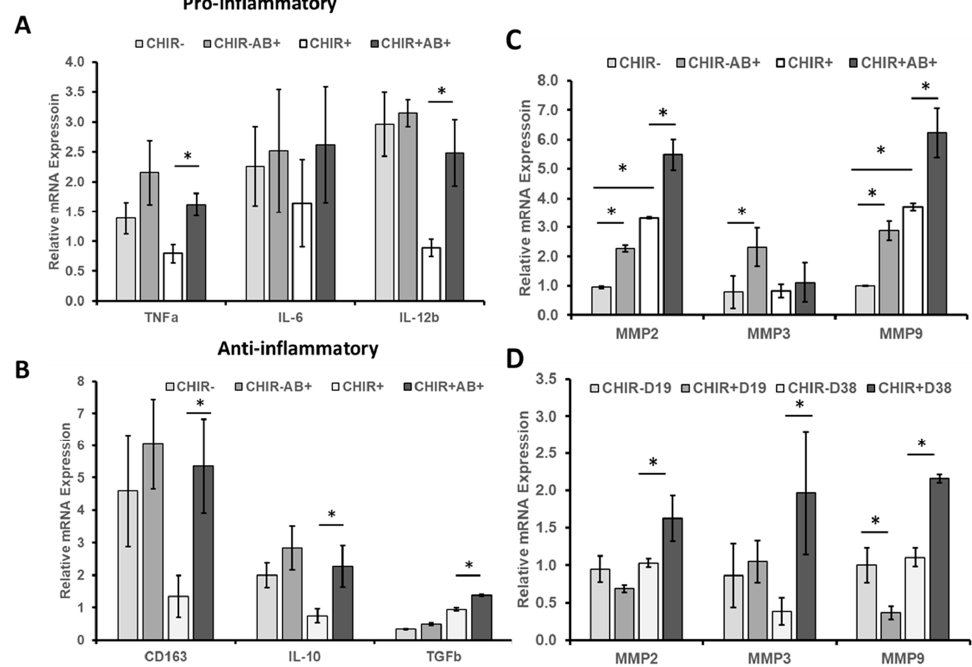
Figure 4. Inflammatory response to A β 42 oligomer stimulation for ChP organoids of CHIR+/ − conditions . mRNA expression determined by RT-qPCR for ( A ) proinflammatory markers (day 33); ( B ) anti-in fl ammatory markers (day 33); these markers were relative to the CHIR+ condition. ( C ) MMP2, MMP3, and MMP9 expression a ff ected by A β 42 oligomers (day 33); ( D ) MMP2, MMP3, and MMP9 expression a ff ected by CHIR at days 19 and 38. N = 3. * indicates p < 0.05. The MMP2, MMP3, and MMP9 expression was relative to the CHIR − D19 condition. CHIR(+/ − ) indicates treatment with CHIR99021, D19 and D38 indicates days 19 and 38, AB(+/ − ) indicates treatment with amyloid β 42 oligomers. The CHIR+ group is more responsive than the CHIR − group.